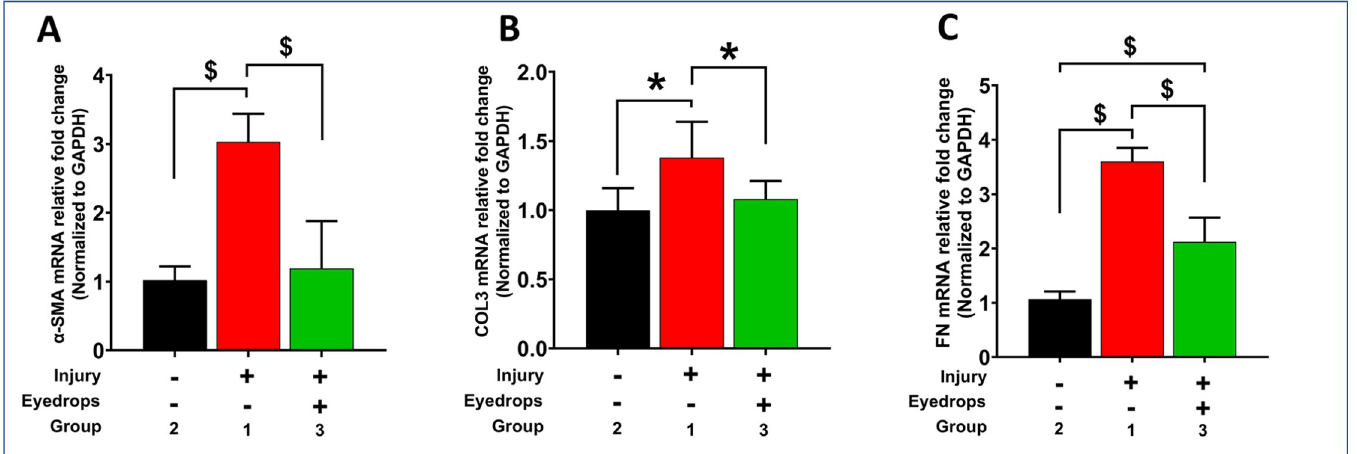
Fig 8. Pro-fibrotic gene expression in na ï ve and wounded eyes -/+ eyedrop. qRT-PCR analysis showing gene expression of α -SMA (A), Collagen-III (B) and Fibronectin (C) in Group-1 alkali treated, Group-2 na ï ve, and Group-3 alkali and eyedrop-treated eyes. A significantly increased α -SMA, Collagen III, and Fibronectin expression was detected in alkali treated corneas compared to the na ï ve corneas, and eyedrop treatment after alkali injury significantly decreased these profibrotic gene’s expression (n = 6 for each group; � = p value < 0.05; $ = p value < 0.0001).